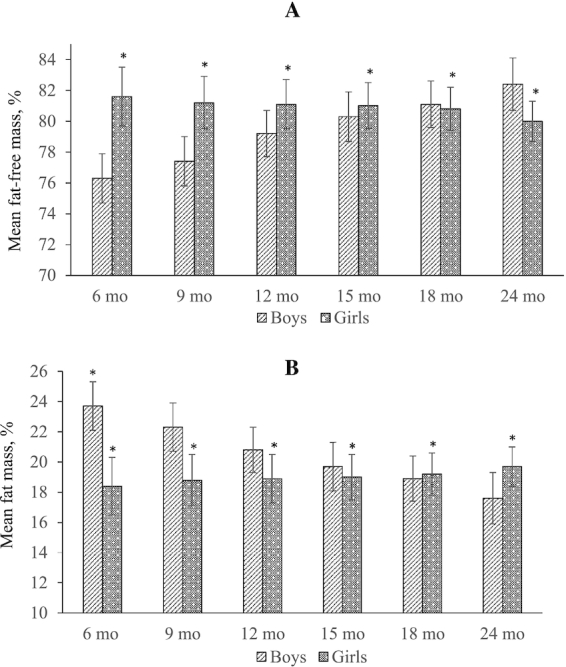
Relative fat-free mass (A) and fat mass (B) of children aged 6–24 mo in Bangladesh randomized to receive 1 of 4 complementary food supplements daily from the age of 6 to 18 mo and a corresponding control group. Values are mean ± SD percent of total body weight represented by each body composition compartment. n = 1793 boys and 1799 girls at each time point. *Different than boys, P < 0.001.